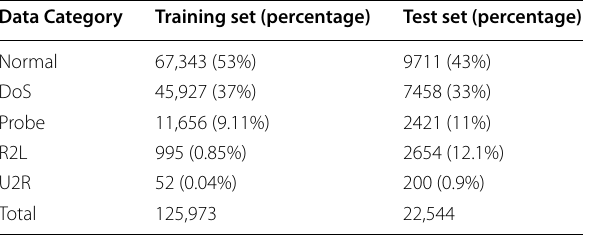
Table 1 NSL-KDD data distribution